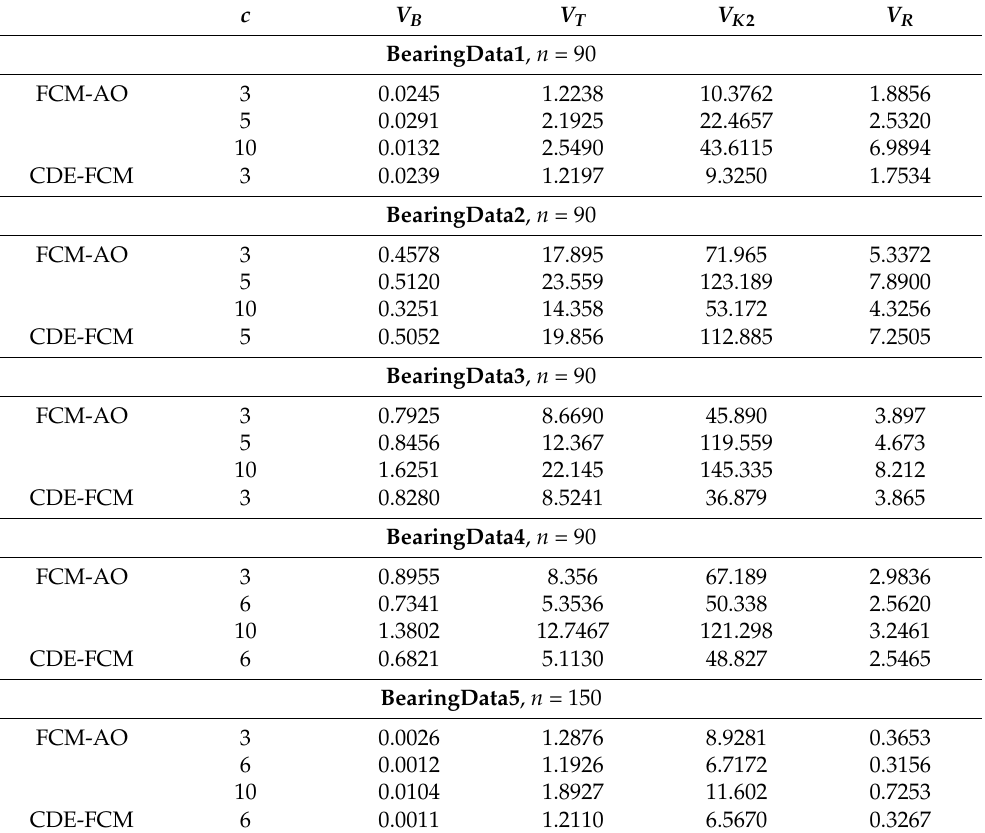
Table 9. Performance of FCM-AO and CDE-FCM for five bearing fault datasets. c V B V